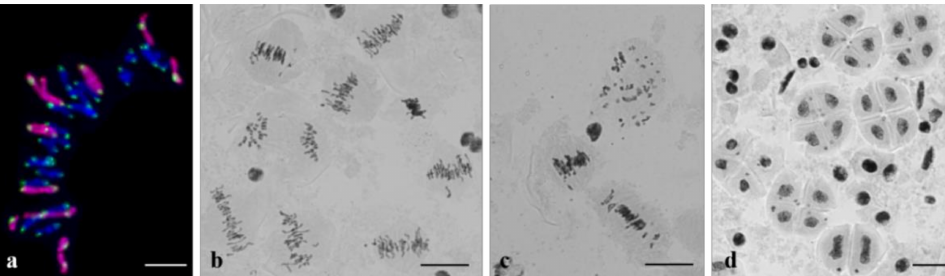
Figure 17. Typical chromosome behavior in meiosis in plants of Group 3: ( a ) Metaphase I; ( b ) metaphase I and anaphase I; ( c ) meiocyte without chromosome pairing; ( d ) tetrads with micronuclei and a dyad amid tetrads. ( a ) GISH; rye chromosomes are labeled red and pAet6-09, green; ( b – d ) acetocarmine. Scale bars = 40 µ m in ( a ) and 10 µ m in ( b – d ). Some cells displayed chromatin breakage and cytomixis (Figure 18). The migration of chromatin between a tapetum cell and a meiocyte was detected at prophase I, at which point its compaction